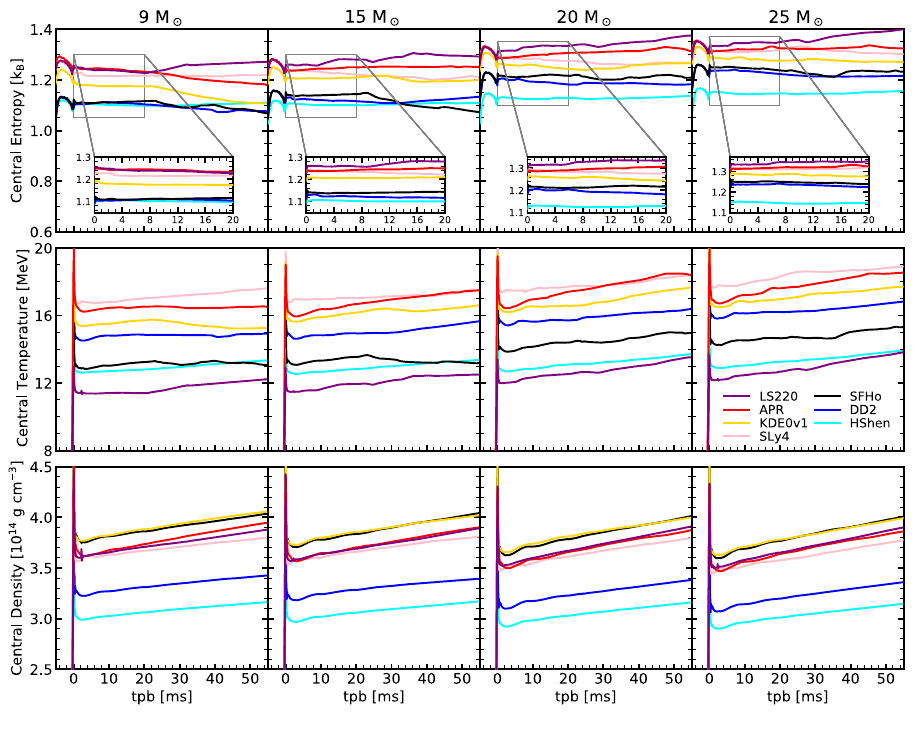
Figure 3. The first three rows show the main central thermodynamic variables for di ff erent progenitors (columns) and EOSs (colors) as a function of time post bounce. The last row shows the ratio of the nu- cleon e ff ective mass to the nucleon mass calculated for the central values of densities and temperatures as a function of time post bounce. The central entropy at early times tpb (cid:2) 5 ms is larger for EOSs that yield stronger explosions. See the text for a more detailed